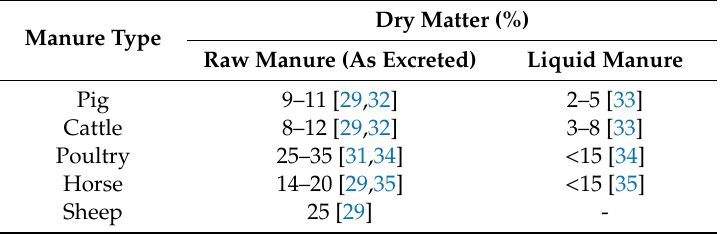
Table2. Comparisonoftypicaldrymattercontentofdi ff